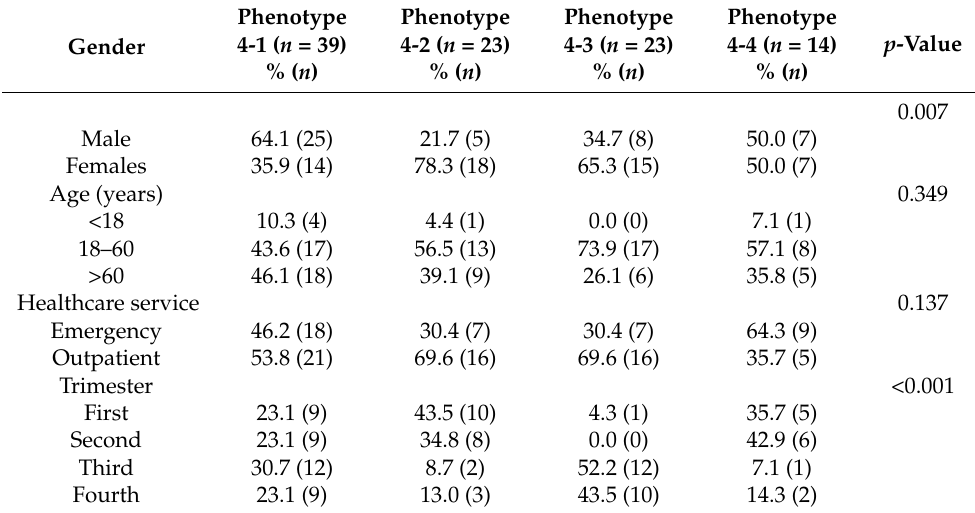
Table 6. Patients’ characteristics by phenotypes